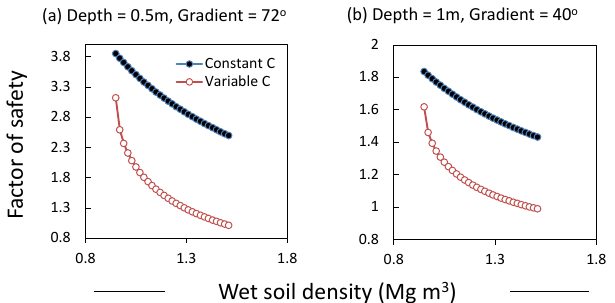
Figure 9. Changes in factor of safety of Shirasu hillslopes with in- creases in wet density with constant cohesion ( C = 5kPa) and co- hesion as a function of soil suction (Sako et al., 2000). Two slope stability cases are considered: (a) shallow slip surface ( d = 0 . 5m) mantle on very steep slopes (72 ◦ ); and (b) deeper slip surface ( d = 1m) on 40 ◦